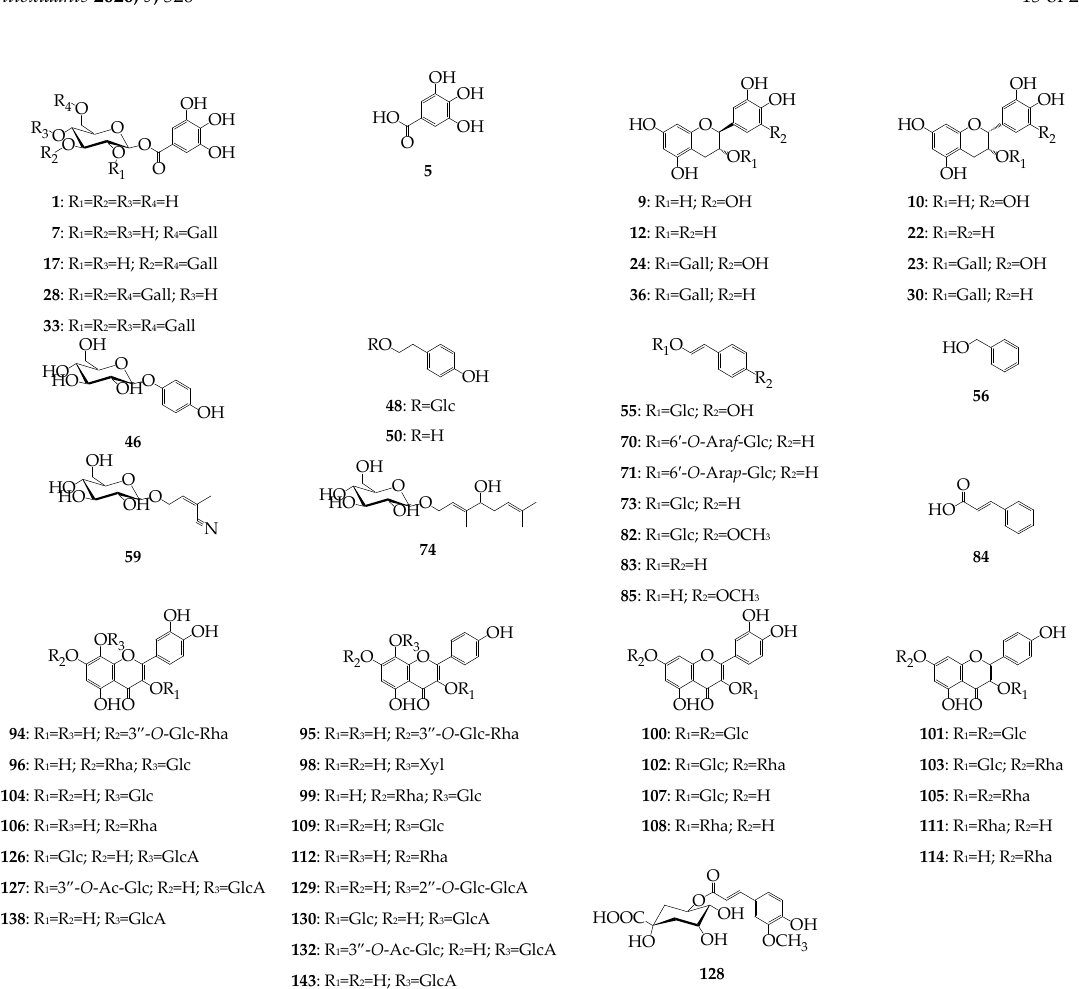
Figure 1. Structures of known compounds found in Rhodiola rosea . Abbreviation used: Ac—acetyl; Ara f —arabinofuranose; Ara p —arabinopyranose; Gall—galloyl; Glc—glucose; GlcA—glucuronic acid; Rha—rhamnose; Xyl—xylose.